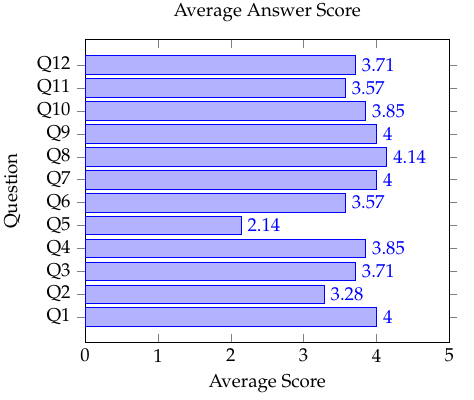
Figure 16. Answer score